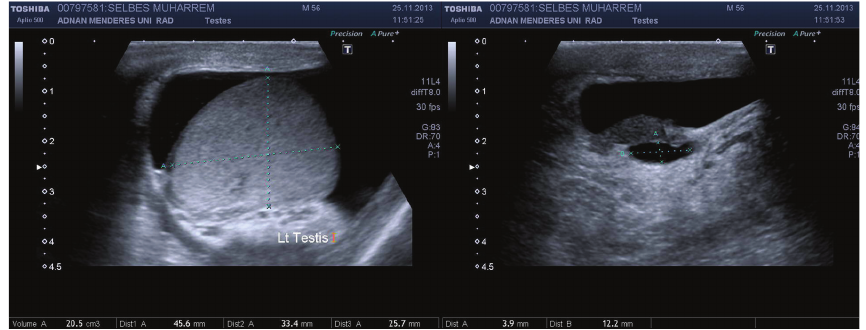
Figure 1: Ultrasonographic images revealed hydrocele and epididymal cyst in the left hemiscrotum.